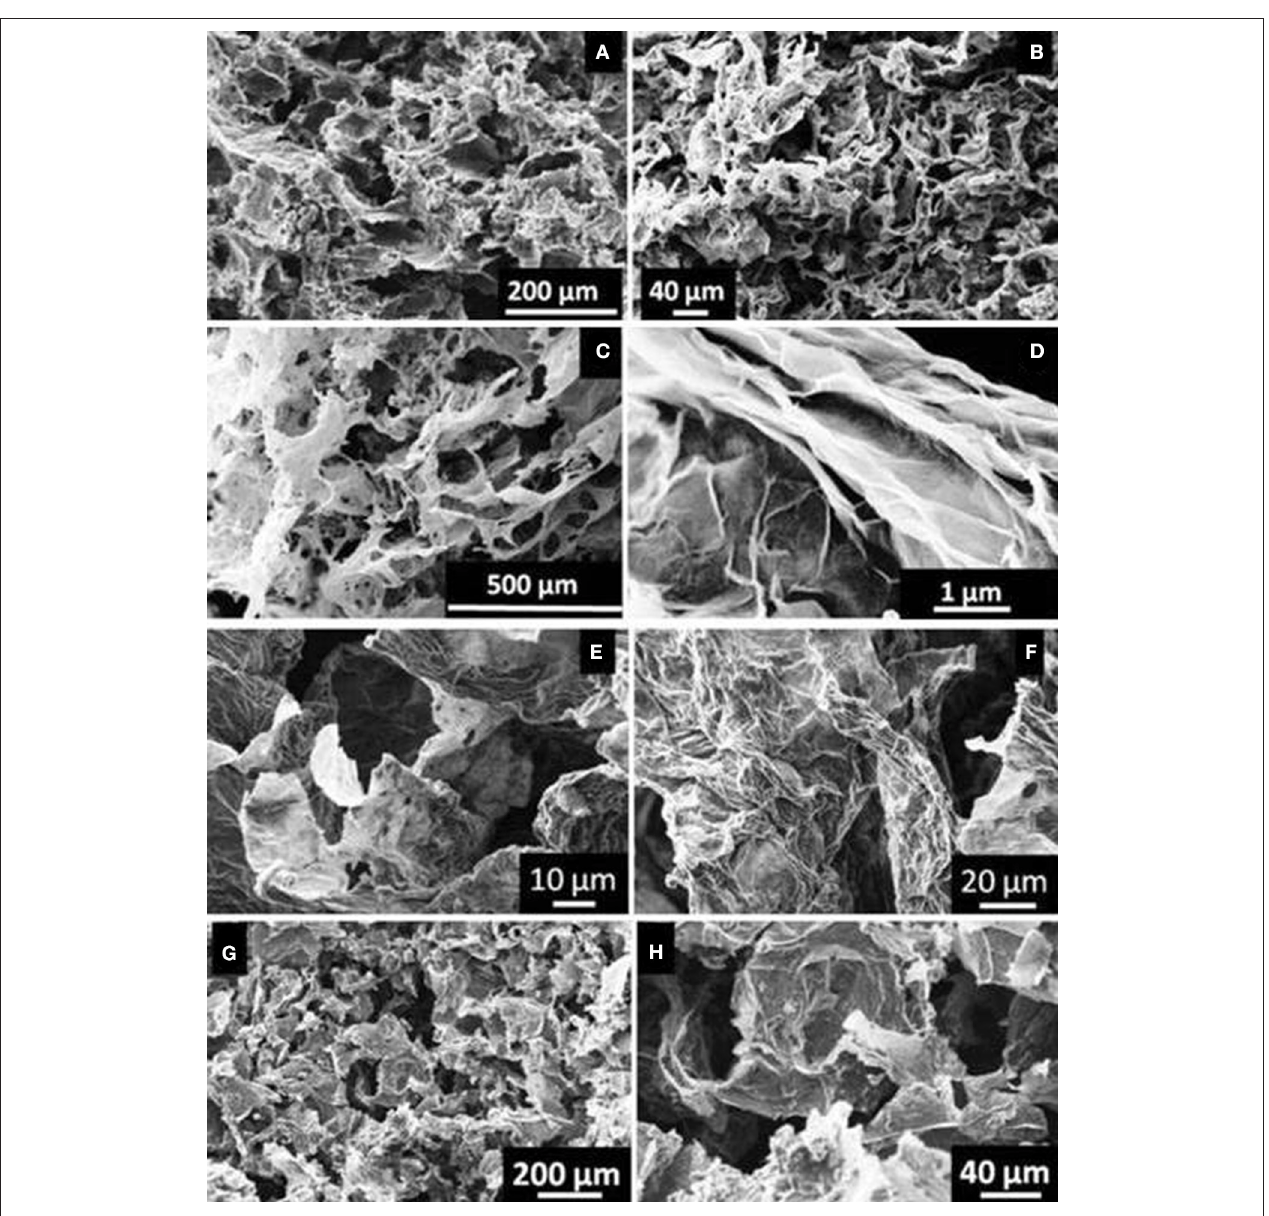
FIGURE 3 | SEM images of (a,b) rGO TETA , (c,d) rGO HDA , (e,f) rGO EDA, and (g,h) rGO PXDA